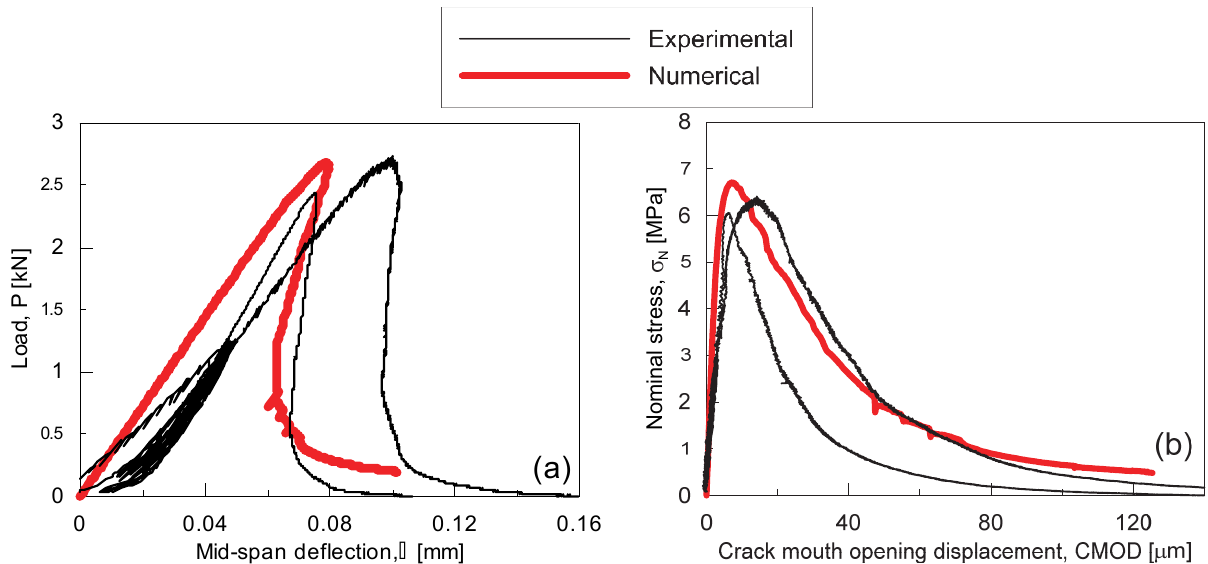
Figure 2: Load vs mid-span deflection curves (a) and nominal stress-CMOD curves (b) for notched specimens under three-point bending. In the graph experimental results for two specimens (black thin lines) are reported along with numerical results (red thick